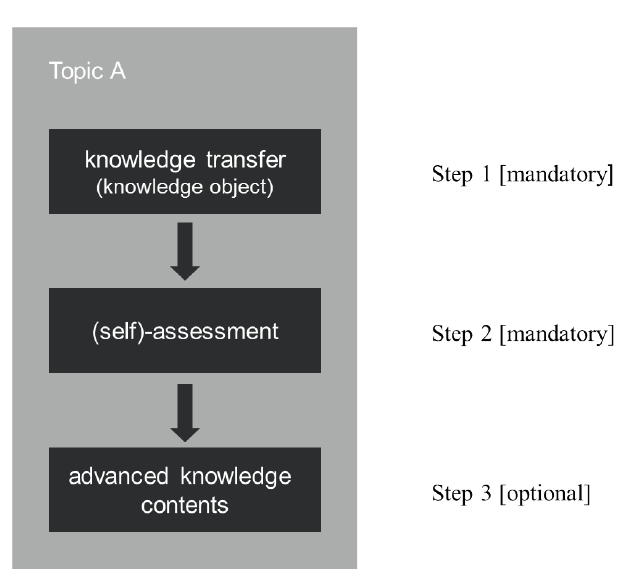
Fig. 4 Three-step approach to the design of an eLearning